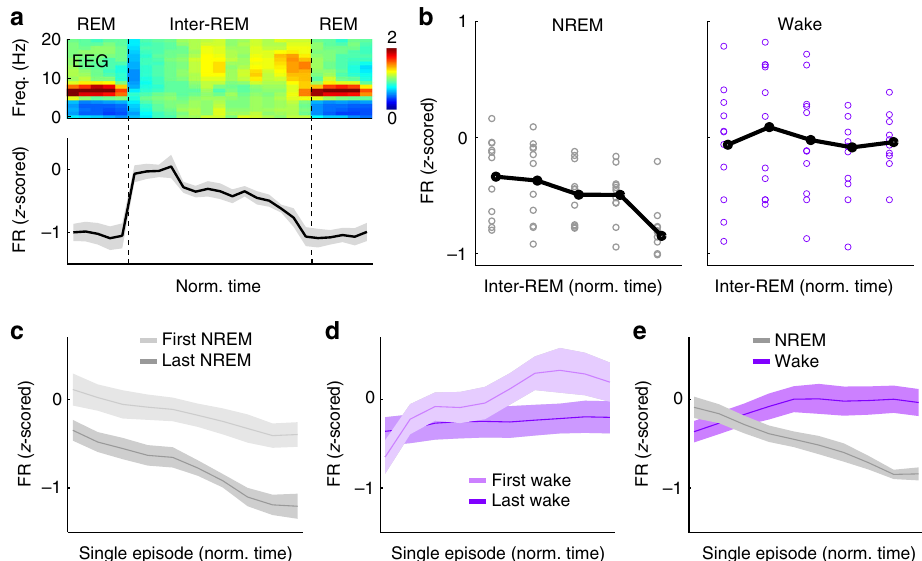
Fig. 5 Slow modulation of vlPAG GABAergic neuron activity during inter-REM interval. a Average normalized EEG spectrogram (upper) and mean fi ring rate ( z -scored) of signi fi cant REM-off vlPAG GABAergic neurons (lower) during two successive REM episodes and the inter-REM interval. Each REM episode and inter-REM interval was temporally compressed to unit length before the fi ring rates were averaged over multiple episodes/intervals and across GABAergic REM-off neurons ( n = 11). Shading, ± s.e.m. b Firing rate (FR, z -scored) during NREM (left) and wake (right) episodes within different segments of the inter-REM interval. Each inter-REM interval was divided into fi ve equally sized bins, and NREM or wake fi ring rates were averaged within each bin. Each symbol represents the average NREM or wake fi ring rate of a unit. The average NREM fi ring rate decreased during the inter-REM period ( R = − 0.48, P = 2.5 × 10 − 4 , T (53) = − 3.93, linear regression), while the wake activity showed no signi fi cant trend ( R = − 0.04, P = 0.76, T (52) = − 0.29). Black line, average fi ring rate of each bin. c Mean fi ring rates during the fi rst (light gray) and last (dark gray) NREM episodes of each inter-REM interval. Each NREM episode was temporally compressed to unit duration before the z -scored fi ring rate was averaged over episodes and across cells. The fi ring rate during the fi rst NREM period was signi fi cantly higher than during the last period ( n = 11 units, P = 0.008, T (10) = 3.28, paired t -test). Shading, ± s.e.m. d Mean fi ring rates during the fi rst (light purple) and last (dark purple) wake episodes of each inter-REM interval. Each wake episode was temporally compressed to unit duration before averaging. e Mean fi ring rates during all NREM (gray) and wake (purple) episodes. Note that the fi ring rate decreased during NREM ( R = − 0.65, P = 2.8 × 10 − 14 , T (108) = − 8.78) but increased during wake episodes ( R = 0.21, P = 0.027, T (108) =